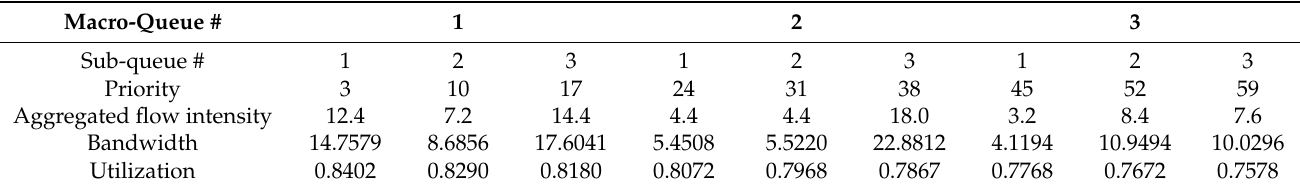
Table 7. The interface bandwidth allocation among the sub-queues of three macro-queues and their utilization.